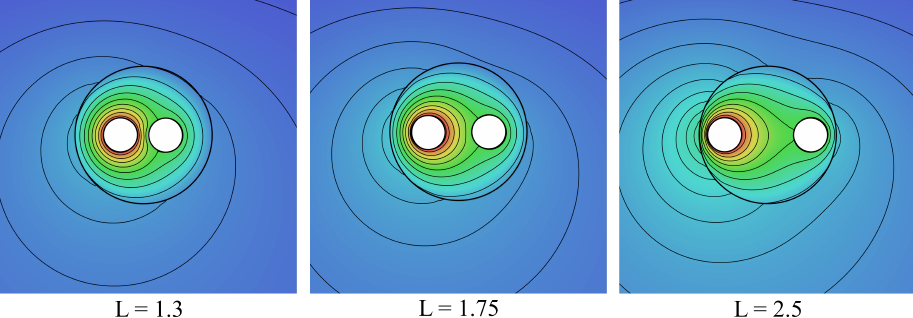
Figure 4. Close-up of the isotherm contour plots for H = 6, W = 4, T r = 0.5, K = 0.1 and L = 1.3 to 2.5.